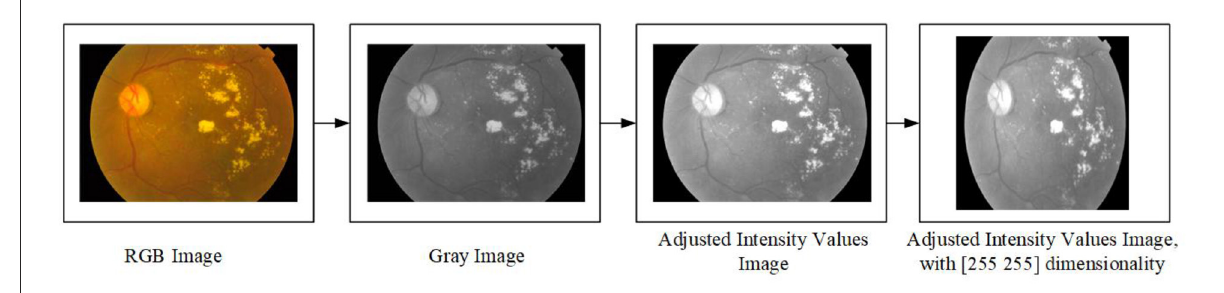
FIGURE2 The pre-processing steps.